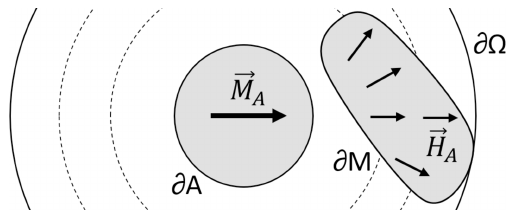
Figure 1. Representation of the domains involved in the reciprocity principle. As an example, the magnet under development, M , out- lined by the boundary ∂M of (cid:127) M , is to create a homogeneous field across the anchor magnet, A , outlined by the boundary ∂A of (cid:127) A . Reciprocally, the field created by anchor magnet x A ∈ (cid:127) A on the magnet volume x M ∈ (cid:127) M is shown and defines the direction that would better create a field in A with a uniform direction. In this case, by wanting to create a homogeneous field in a circle, the end solution for the magnet M under development is the well-known Halbach